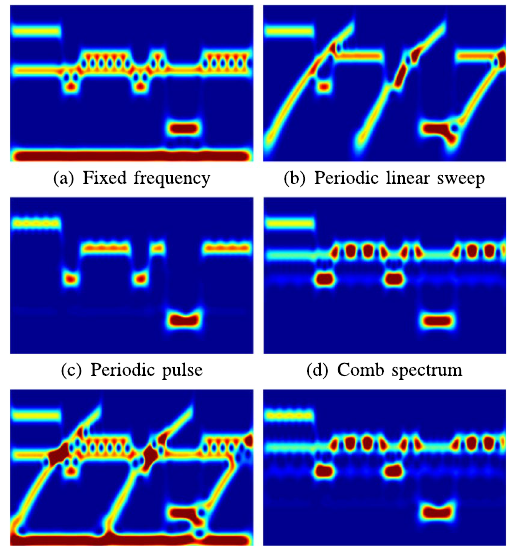
Fig. 6 Spectrogram images of different interference